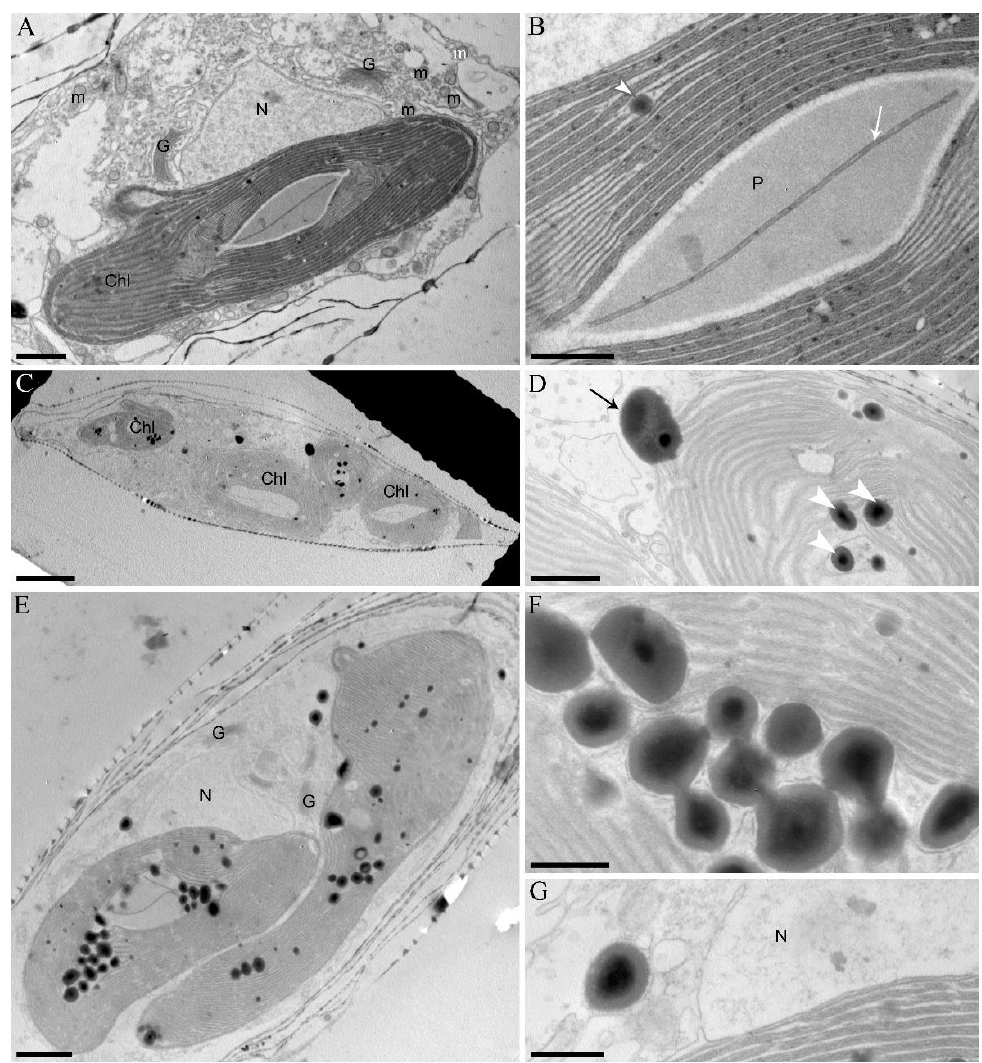
Figure 3. Cell ultrastructure of E. cf. paludosa (TEM). Lipid droplets of cells at exponential ( A , B ) and stationary ( C – G ) stages are marked by short white arrows ( B , D ). The lamella penetrating the pyrenoid ( B ) is marked by long white arrow. The lipid droplet located on the bound of chloroplast and cytoplasm is marked by long black arrow. Legend: Chl — chloroplast; G — Golgi apparatus; m — mitochondrion; N — nucleus. Scale bars: ( A , D ) — 1 µm; ( B , F , G ) — 500 nm; ( C ) — 5 µm; ( E ) — 2 µm.